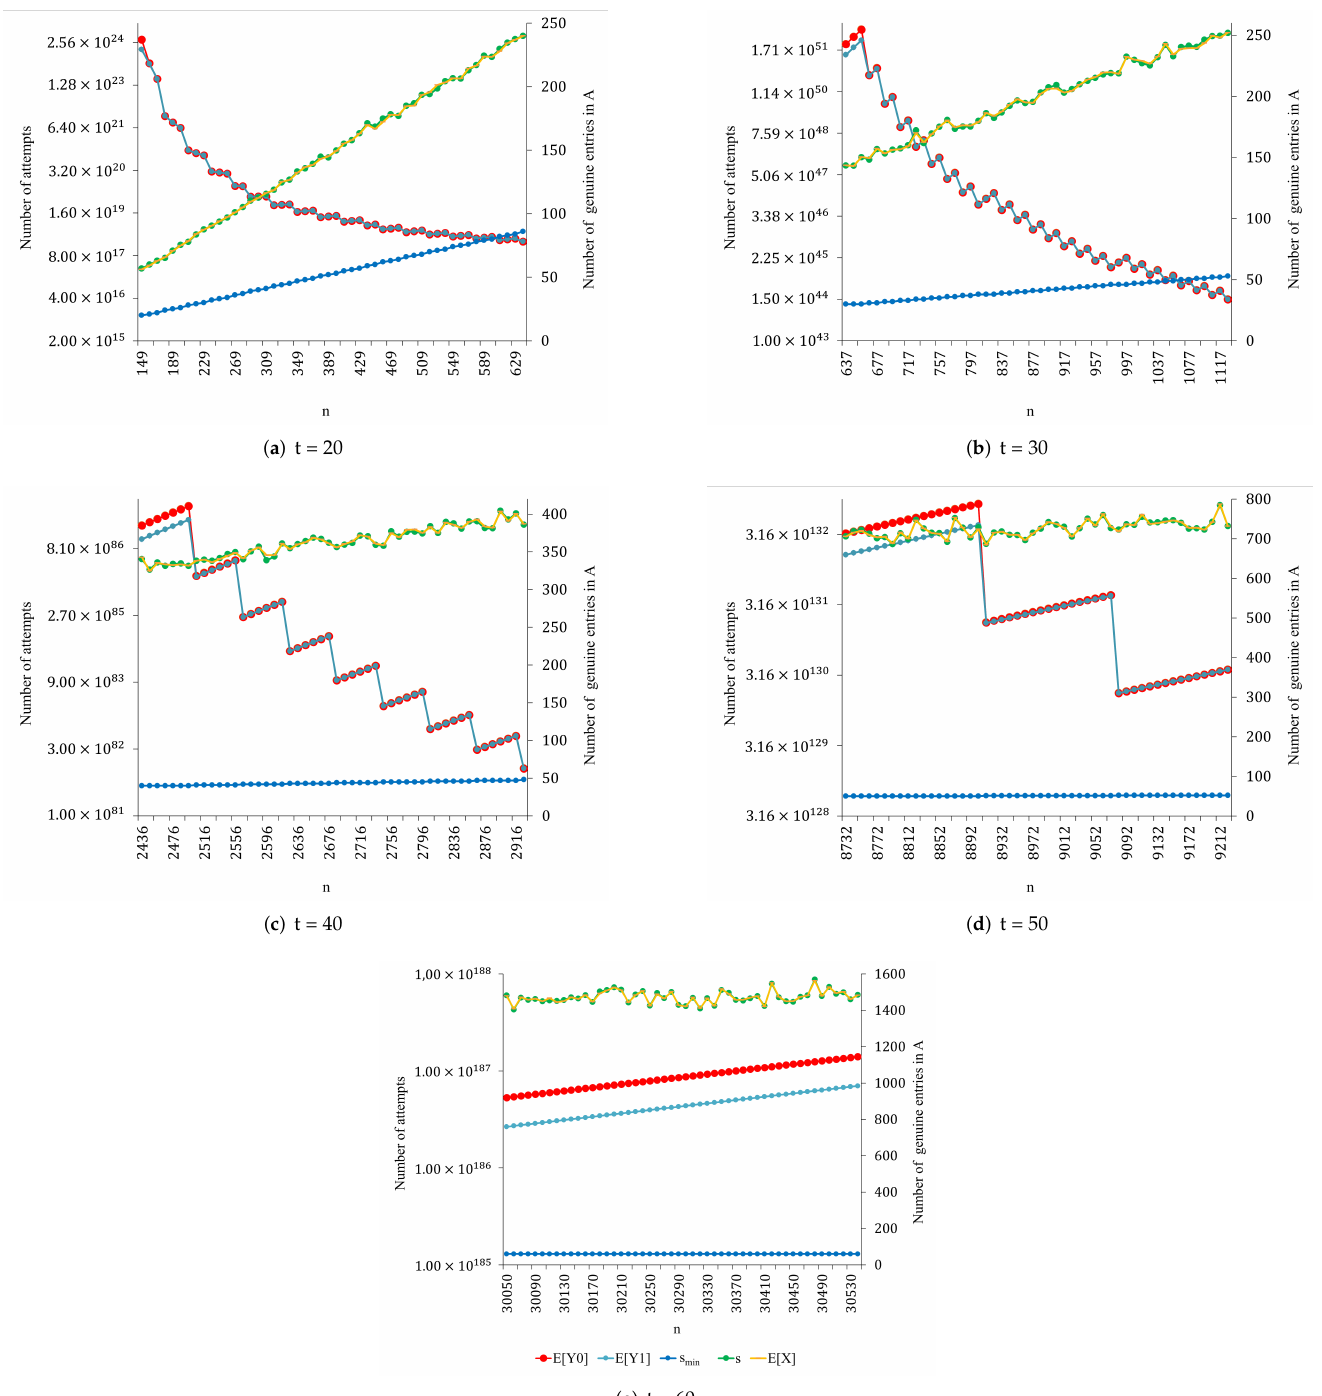
Figure 2. Results obtained for p min = 0.90 ∈ P , t ∈ T , and proper values of n